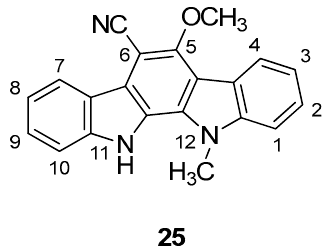
Figure 11. Structure of 6-cyano-5-methoxy-12-methylindolo [2,3-a]carbazole ( 25 ).